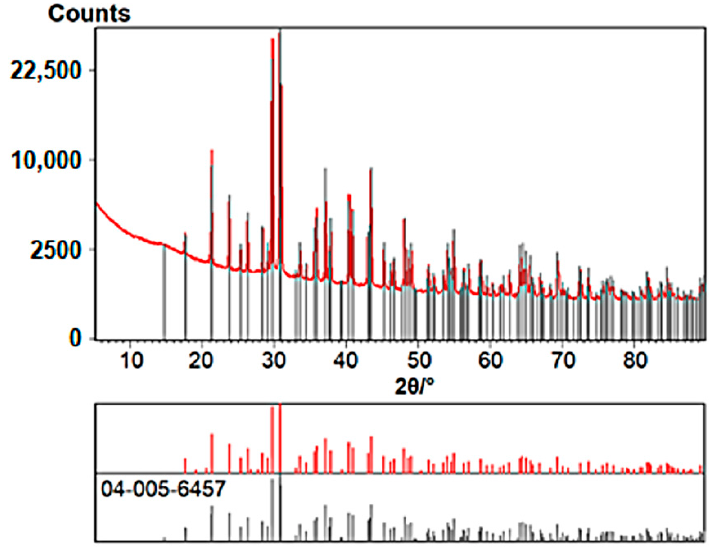
Figure 8. An identification of the decomposition product of 1 isolated from an experiment in air at 600 °C. The presence of potassium sulfate(VI) (Ref. Code 04-005-6457—K 2 SO 4 ) was proved using the ICDD PDF4+2021 diffraction database.